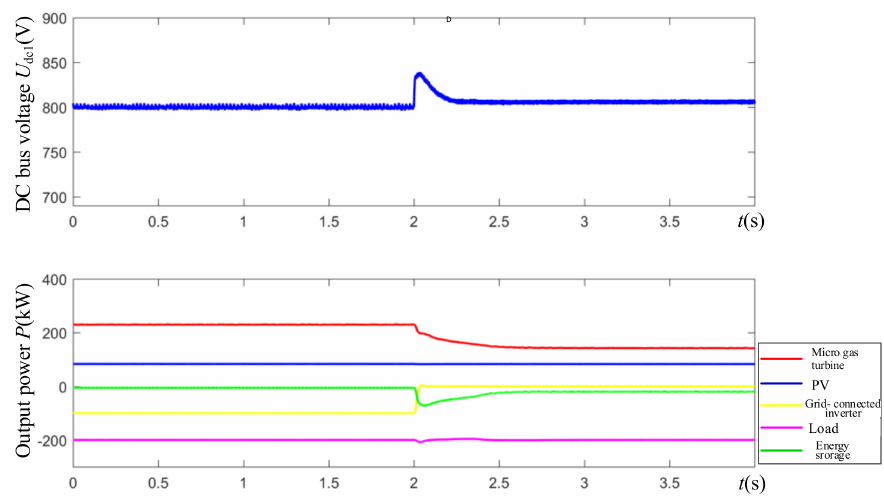
Figure 14. System response in off-grid